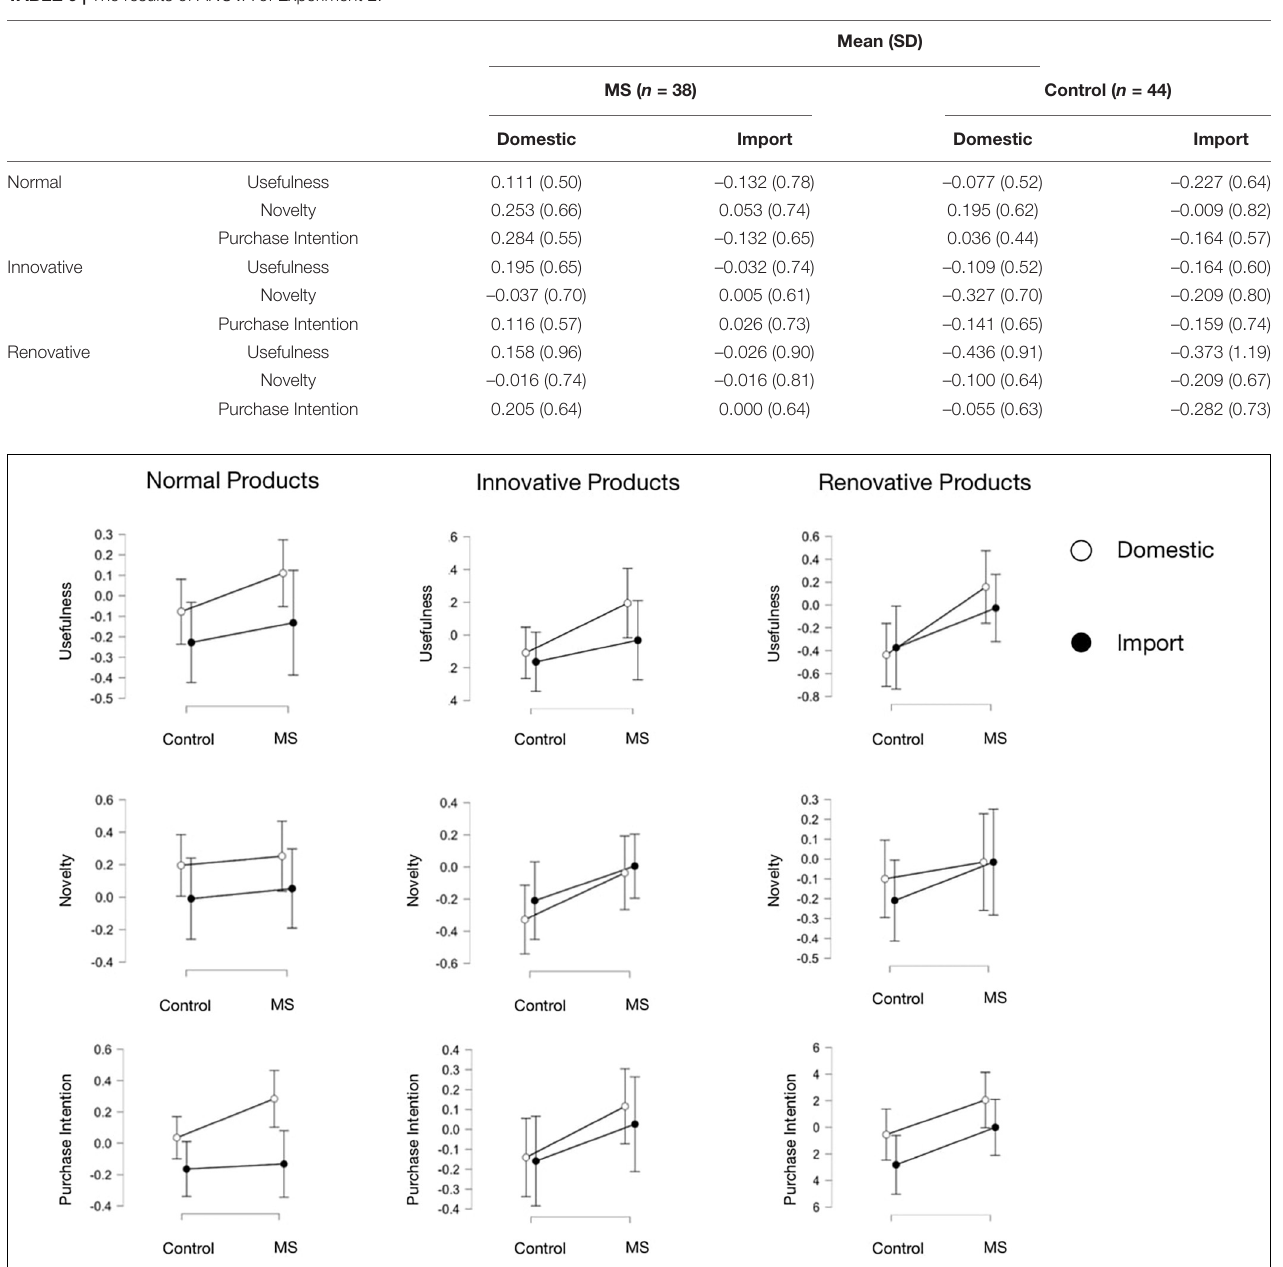
TABLE 6 | The results of ANOVA of Experiment 2.